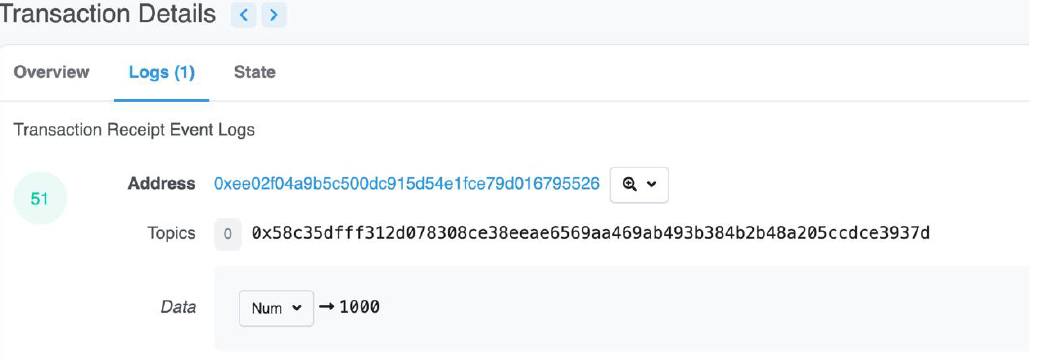
Figure A6. Logs of minting currency tokens transaction on Etherscan, amount was shown in the Data field.